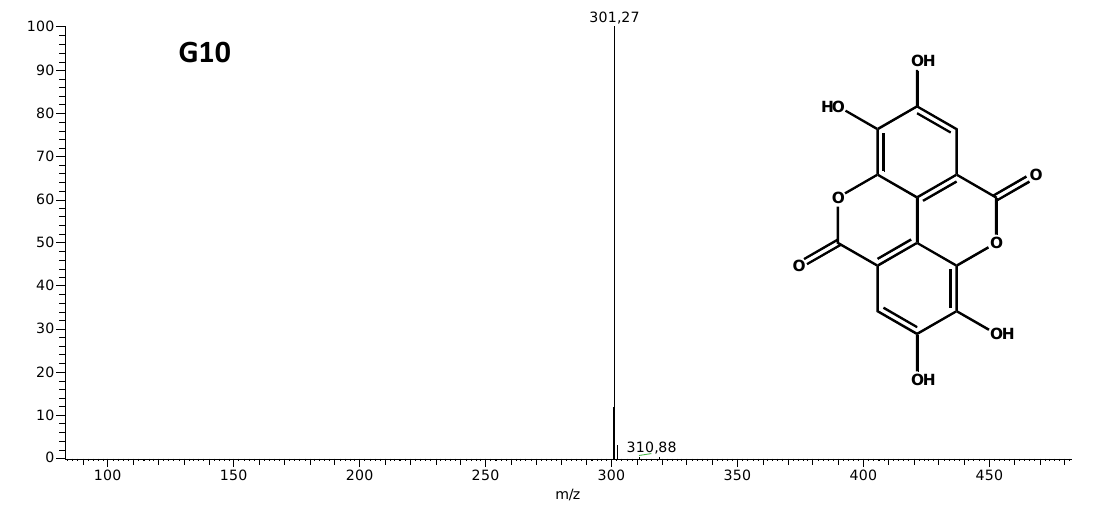
Figure 1. Mass spectrum of Group 10, obtained by flow injection analysis-electrospray ionization-ion trap mass spectrometry (FIA-ESI-IT/MS), ionization by negative mode and structure of the isolated compound (Ellagic acid). Table 2. Chemical characterization of G10 by